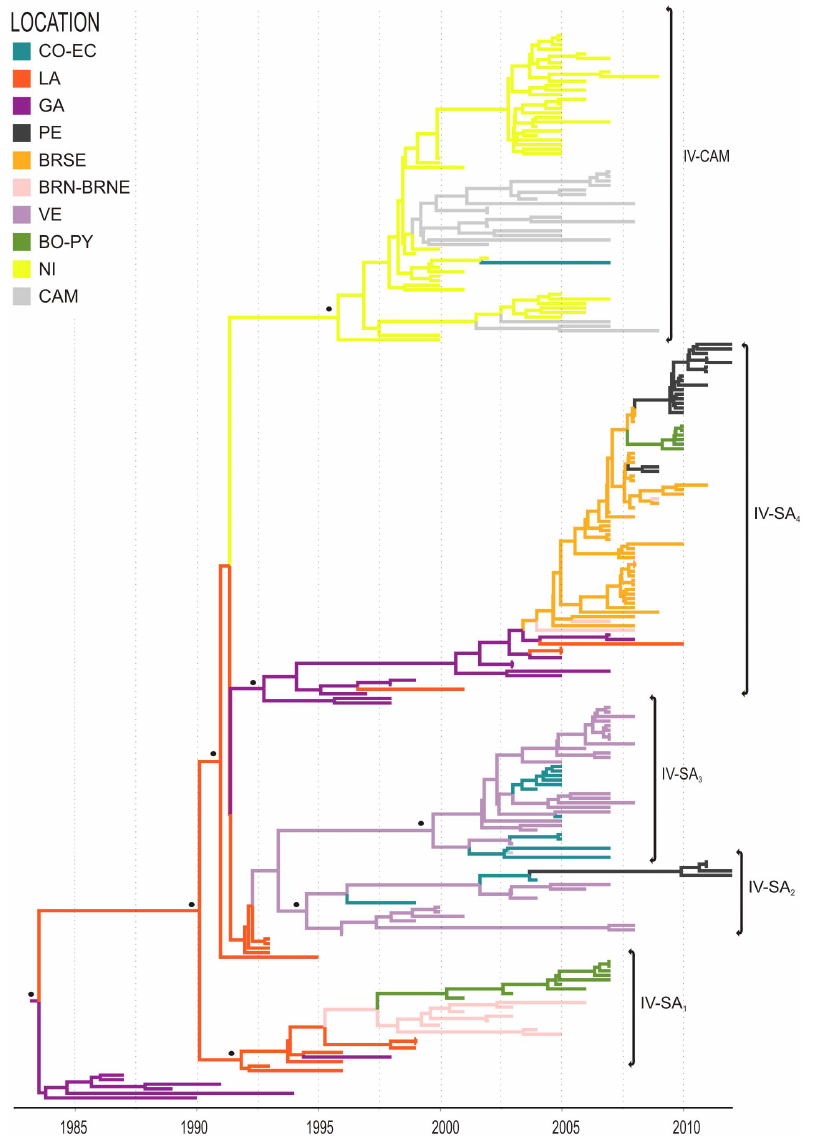
Figure 6. Time-scaled Bayesian Maximum Clade Credibility sub-tree corresponding to the Clade IV. Five major highly supported monophyletic clades: IV-SA 1–4 and IV-CAM are identified within clade IV. For further details see legend of Fig 4. (CO-EC: Colombia-Ecuador, LA: Lesser Antilles, GA: Greater Antilles, PE: Peru, BRSE: Brazil Southeastern, BRN–BRNE: Brazil Northern-Brazil Northeastern, VE: Venezuela, BO-PY: Bolivia- Paraguay, NI: Nicaragua, CAM: Central